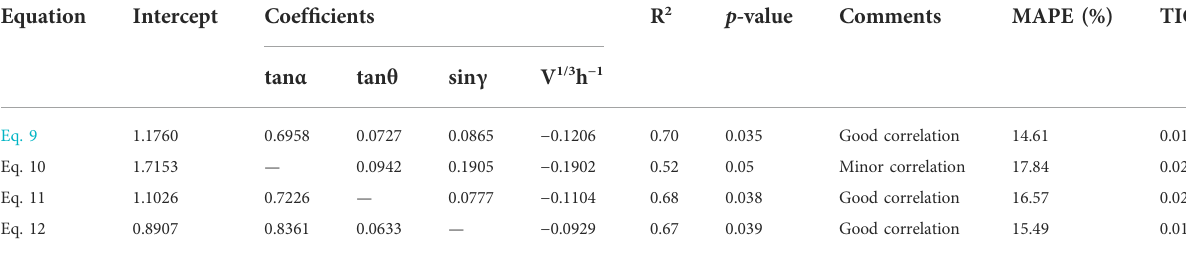
TABLE 4 Comparison of the regression results for different empirical models using different independent topographic variables. Equation